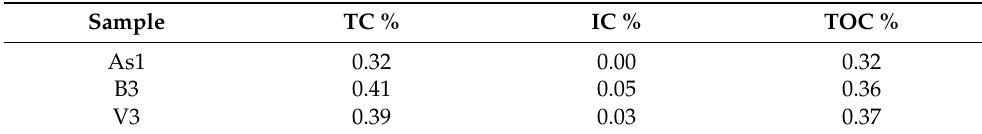
Table 4. Percentages of analyzed carbon in the chert samples selected.